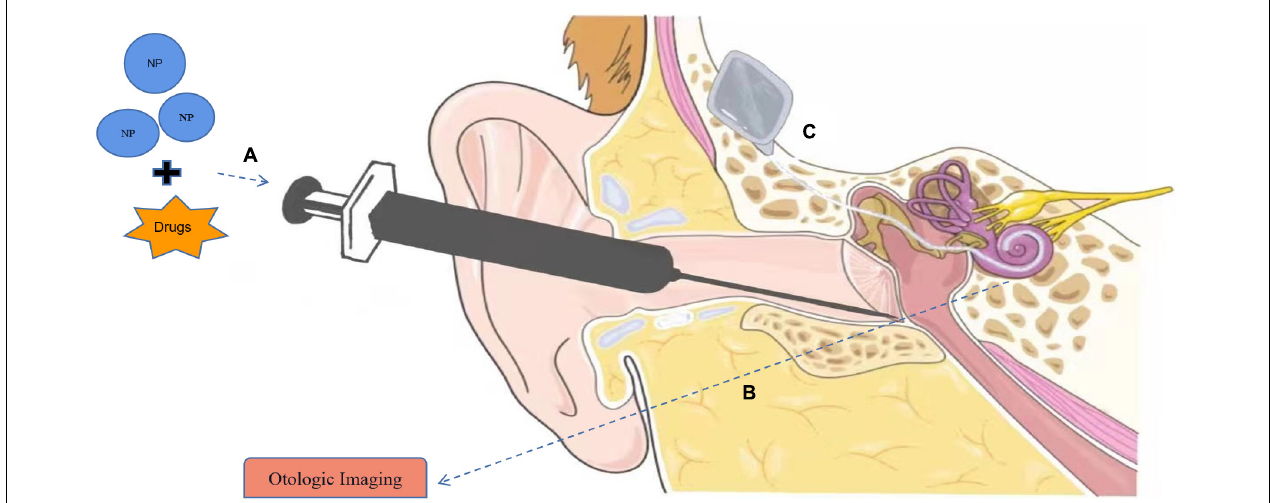
FIGURE 1 | Applications of nanomaterials in hearing loss. (A) Nanoparticles (NPs) can serve in drug delivery systems to the inner ear with intratympanic (IT) injection. (B) Nanomaterials can be used as contrast agents in otologic imaging. (C) Application of nanomaterial in cochlear implants (CIs). Part of the material in Figure is from